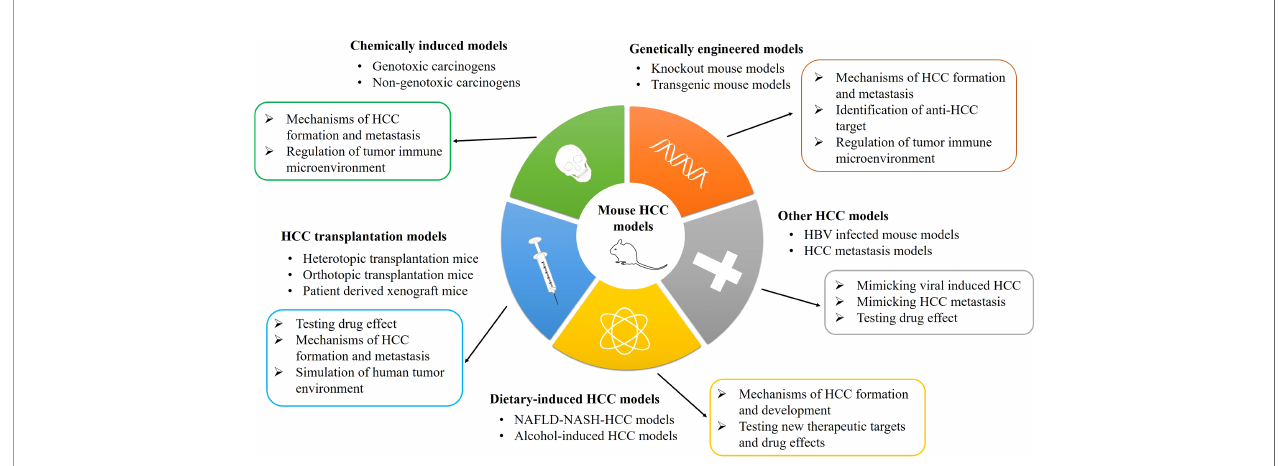
FIGURE 1 | The classi fi cation, advancement, and application of mouse HCC models. HCC, hepatocellular carcinoma; HBV, hepatitis B virus; NAFLD-NASH, non- alcoholic fatty liver disease-non-alcoholic